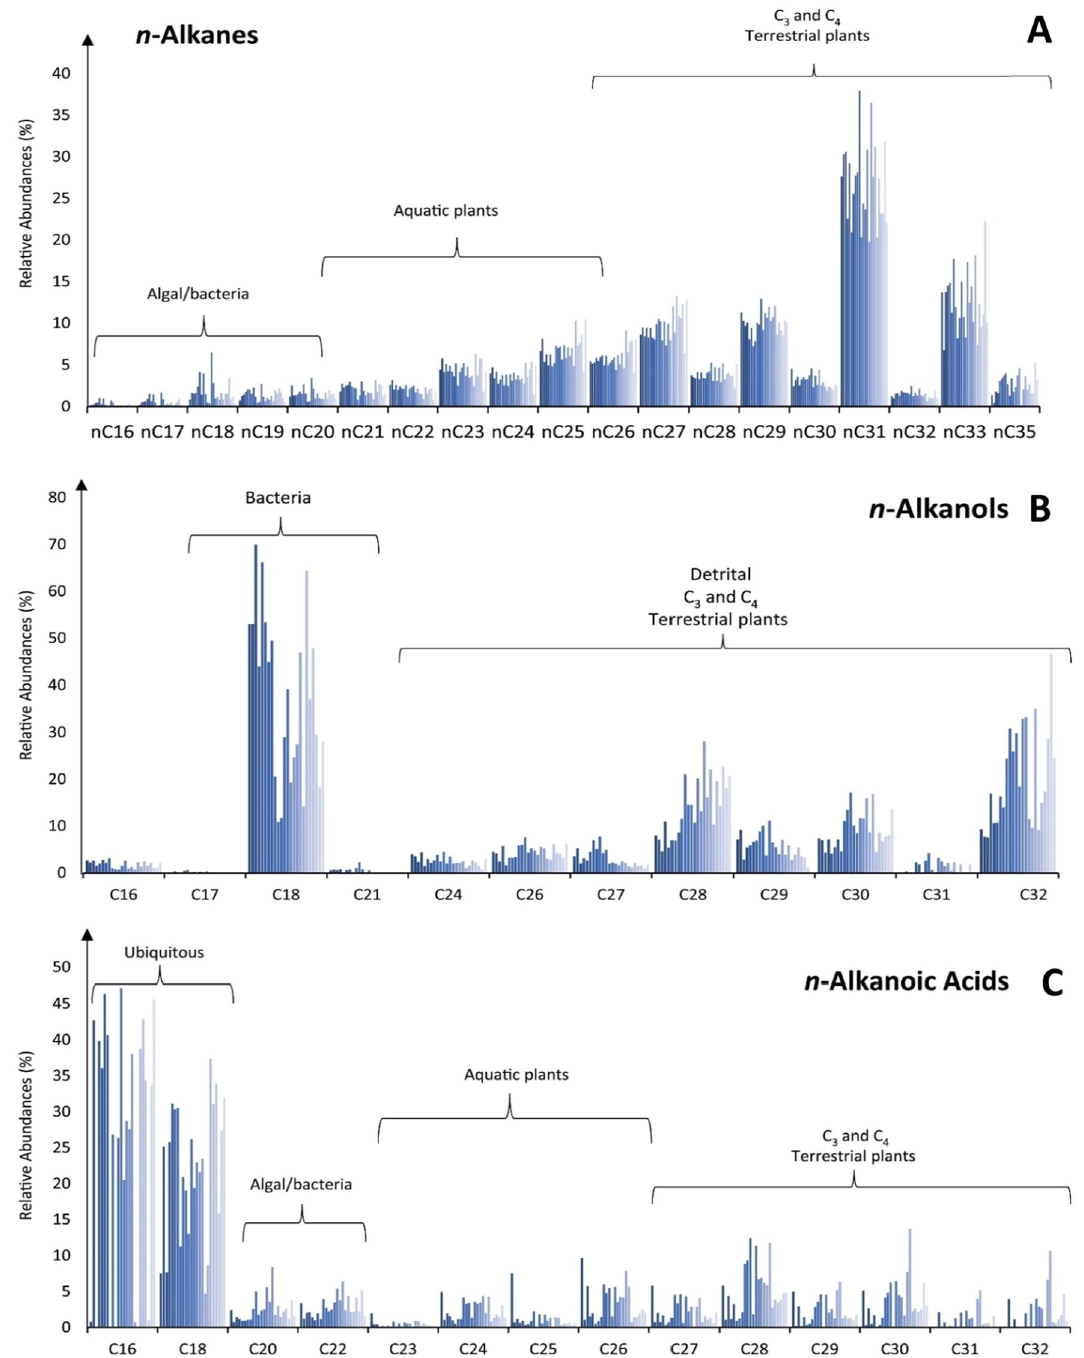
Figure 2. Lipid distributions and the relative abundances of key polarity fractions identified through GC– MS analyses. ( A ) n-Alkanes; ( B ) n-Alkanols; ( C ) n-Alkanoic acids. Diagnostic source associations are also shown 19,20,24–26,35,65 portional dominance of floating/submerged (i.e., aquatic) macrophytes as compared to emergent macrophytes and terrestrial plants. Samples at AGS feature consistent P aq values of between about 0.1–0.4 (Fig. 3A) indicative of high input from floating and emergent macrophytes such as cattails ( Typha sp.). P alg values, a ratio of the algal lipids relative to algal plus terrestrial lipids 20 , of < 0.1 further indicate nominal lipid input from algae at AGS (Fig. 6C) that is inconsistent with swamp or salt-marsh habitats, which are rich in edaphic algal biomass 6,21 . Together with intermediate values of the n C 33 / n C 31 ratio of 0.2–0.7 (average of ~ 0.6), in which higher values suggest increasing grass cover 22,23 , we interpret AGS to have been covered in mostly graminoids. Analysis of intermediate polar (i.e., functionalized) lipid fractions illuminate crucial details about the paleoen- vironment at AGS that biomarker n -alkanes alone cannot. Major n -alcohols in our sample extracts include